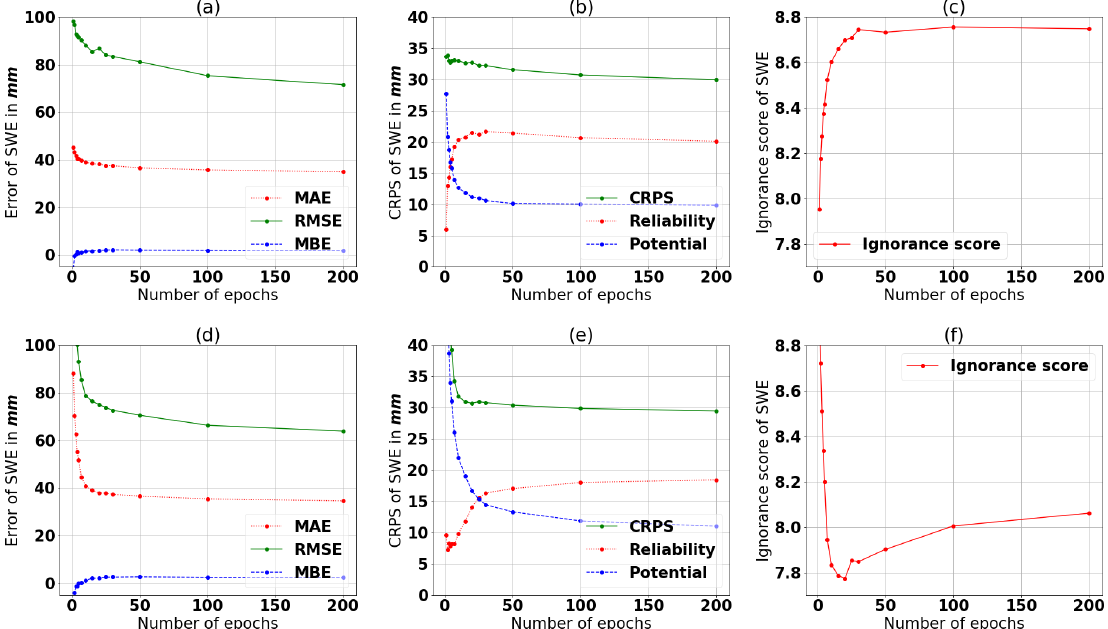
Figure 5. Comparison of (a–c) snow density and (d–e) SWE as target variables. Panels (a) and (d) show the accuracy measures MAE, RMSE, and MBE; panels (b) and (e) show the CRPS and its decomposition; and panels (c) and (f) show the ignorance score. The scores are evaluated using the validation data set. We use the Reference setup presented in Table 2. Table 3. Comparison of all tested characteristics worth considering. The number of epochs is selected so that the trade-off between reliability and accuracy of the ensemble is increased. The numbers in bold indicate an improvement throughout the testing. Combo combines para. init. 3 , shuffled data, and input uncertainty and is used as the final setup. Ref.